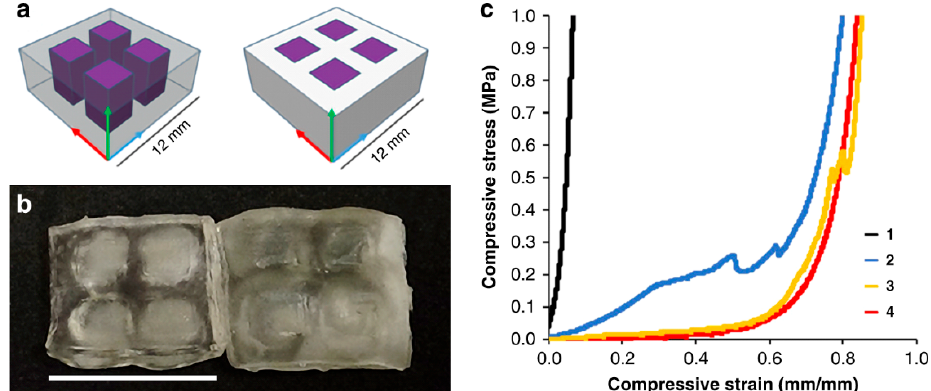
Figure 51. ( a ) 3D model of four-pillar multi-material objects. Purple corresponds to pillars printed with UV light, while the white/transparent outer region corresponds to domains printed with visible light. ( b ) Printed multi-material structures prior to thermal post-curing (left) and after thermal post-curing at 60 °C for 3 h (right). ( c ) Representative compressive stress–strain plots of multi-material 3D printed test specimens. Black curve (1) = Sample cured with UV light. Blue curve (2) = Multi-material sample compressed along the z-axis. Yellow curve (3) = Multi-material sample com- pressed along the x-axis. Red curve (4) = Sample cured with visible light [320].